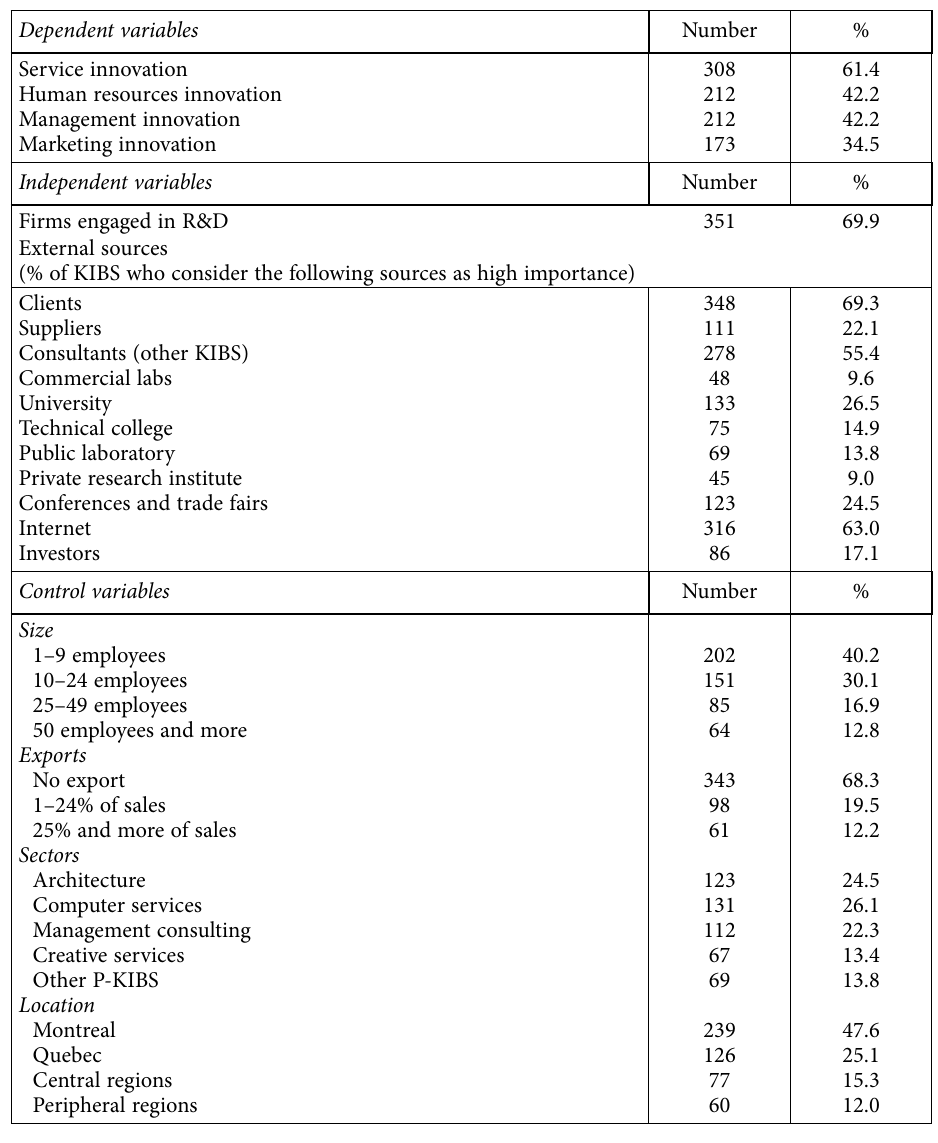
Table 1. Descriptive